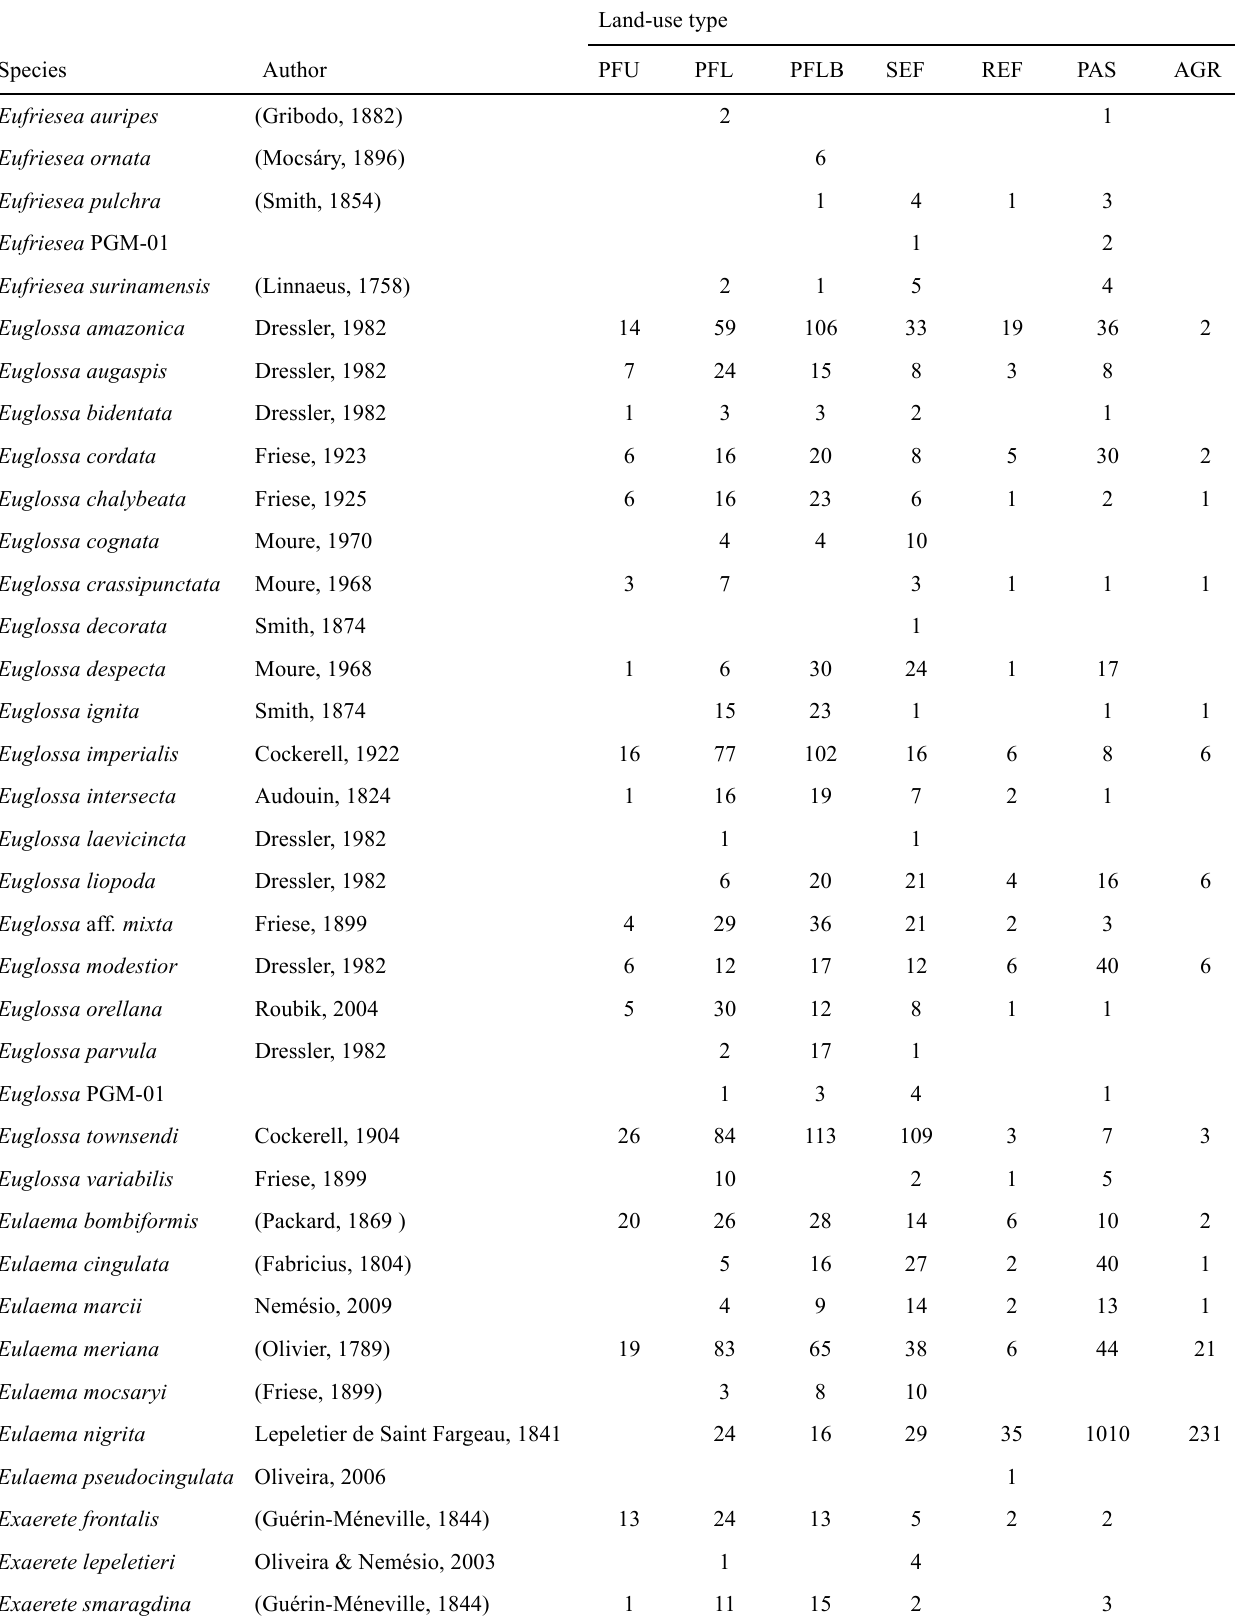
Table 3 . List of orchid bees species collected in this study. Values represent the number of individuals of each species in each land-use type: PFU – primary forest undisturbed, PFL – primary forest logged, PFLB – primary forest logged and burnt, SEF – secondary forest, REF – reforestation with commercial species, PAS – pasture, AGR – agricultural